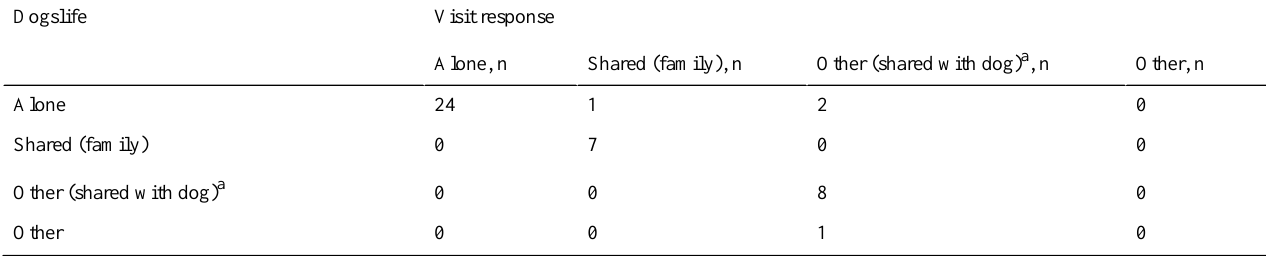
Table 2. Comparison of sleeping location in Dogslife record with visit response. Numbers entered refer to the count of households. Visit